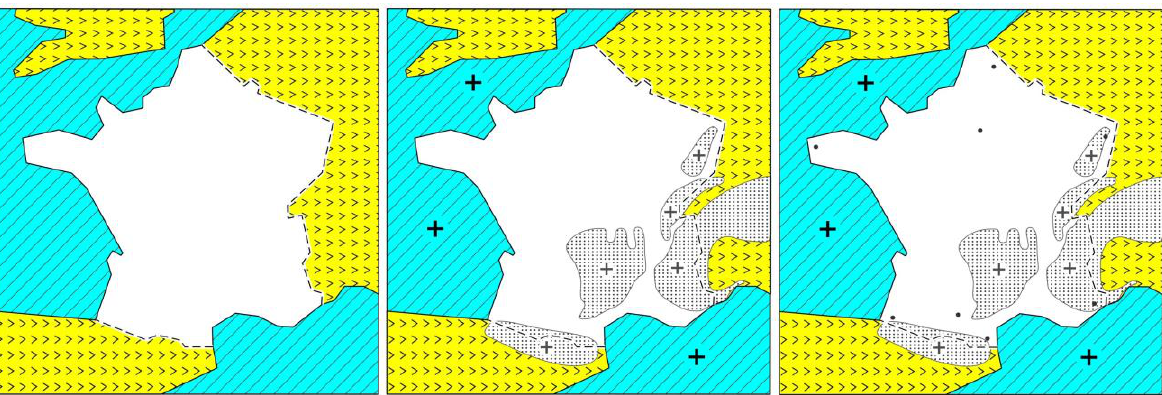
Figure 3. Example of three raised-line maps edited with the Open Street Map editor. The map on the left show the base map that has been used to create the two others maps by adding the ocean, sea and mountains (in the middle) and the main cities of France (on the